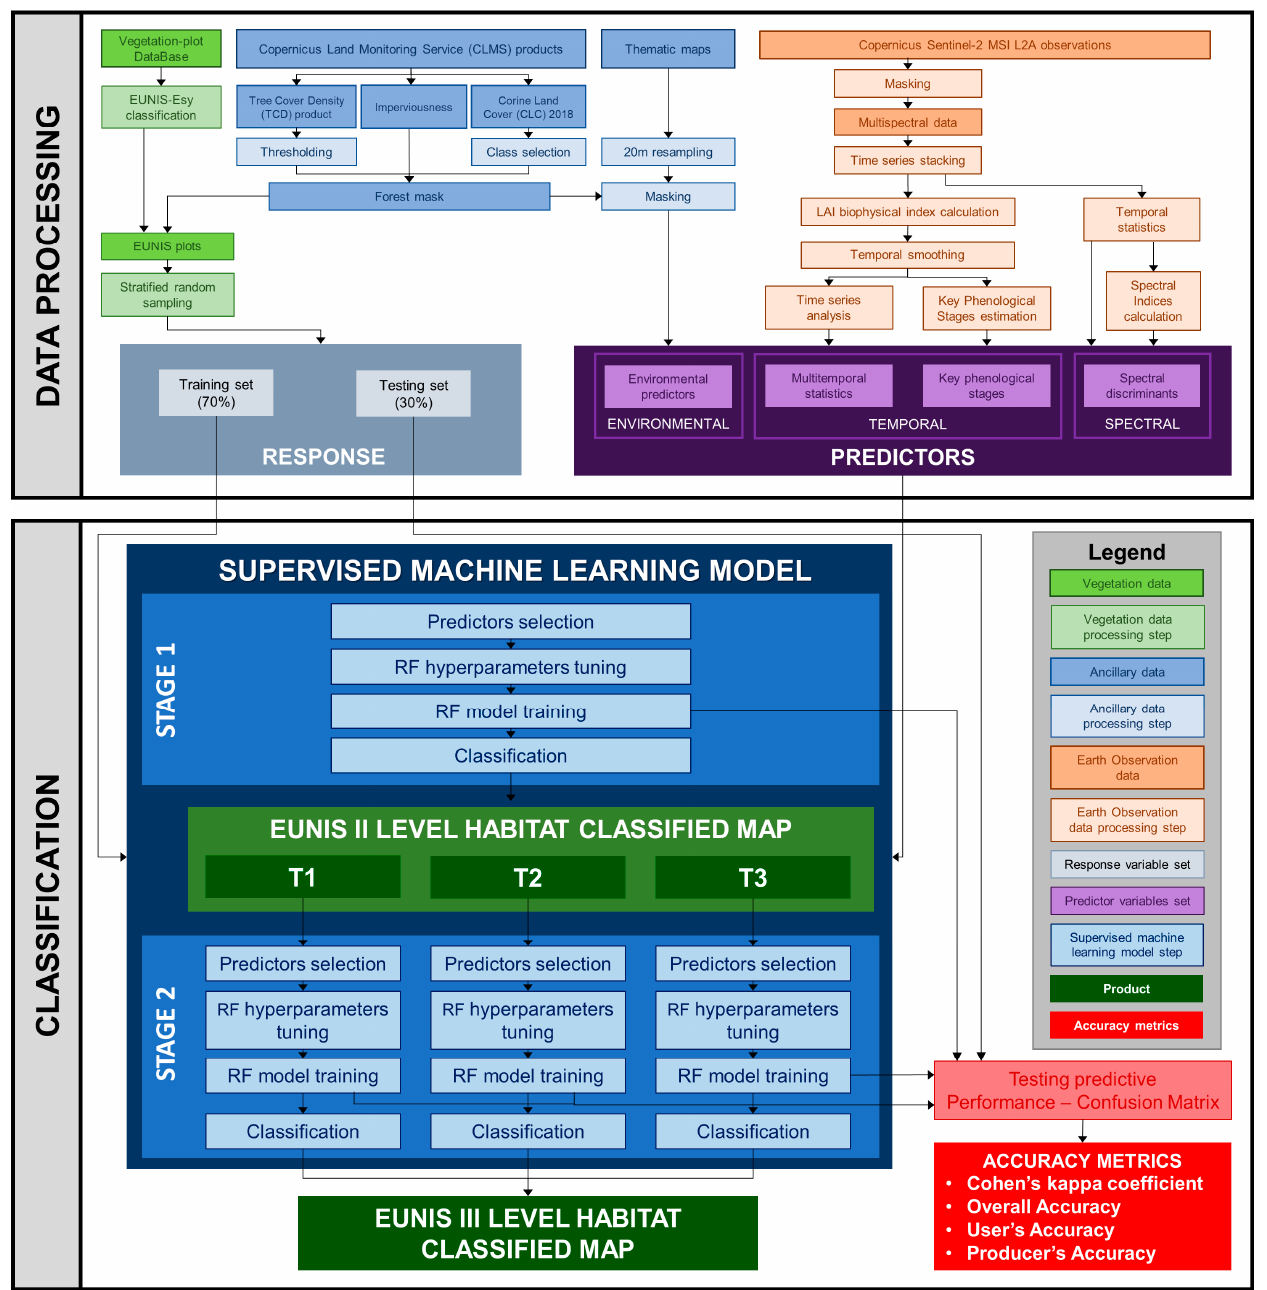
Figure 1. Flowchart of the approach for forest habitat mapping using a supervised machine learning model. For more details about EUNIS codes (i.e., II and/or III level) see Table 3.